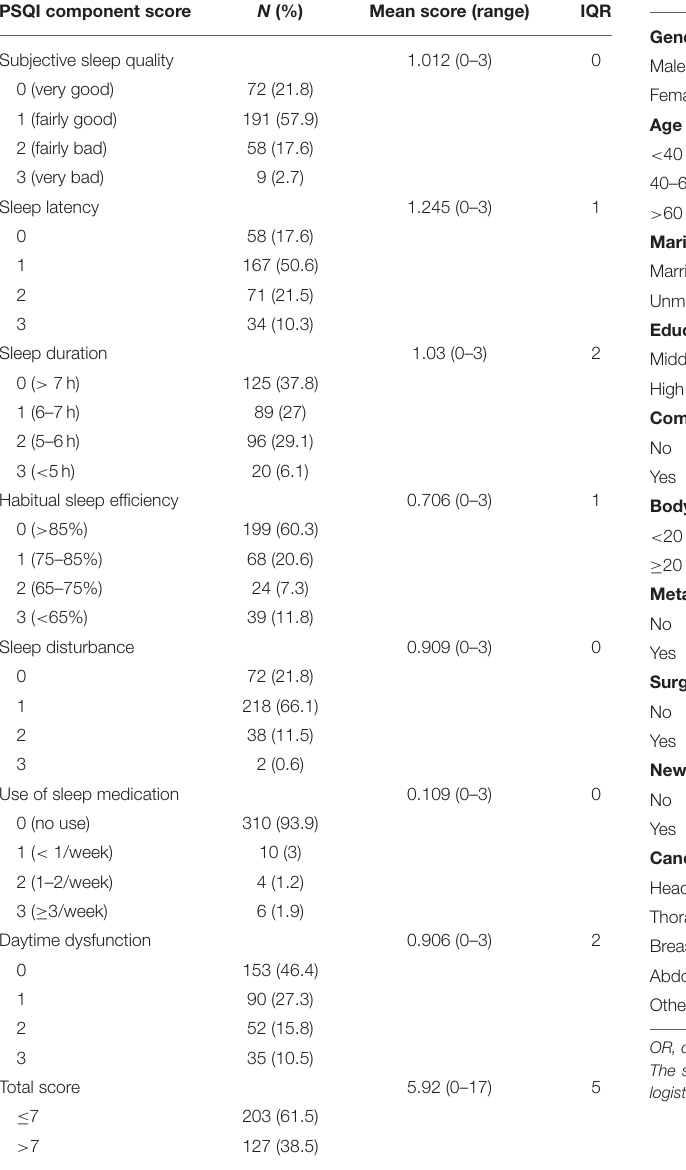
TABLE 2 | Descriptive statistics for the scores of the seven pittsburgh sleep quality index components in cancer patients. PSQI component score